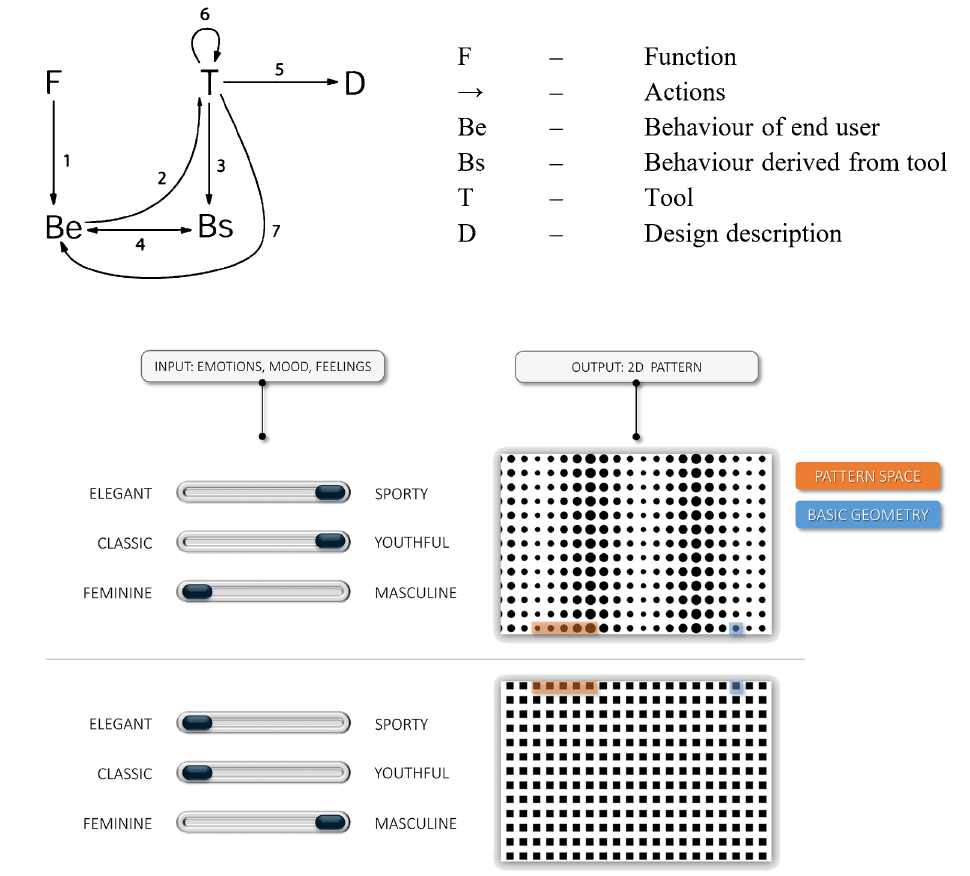
Fig. 2 Concept of